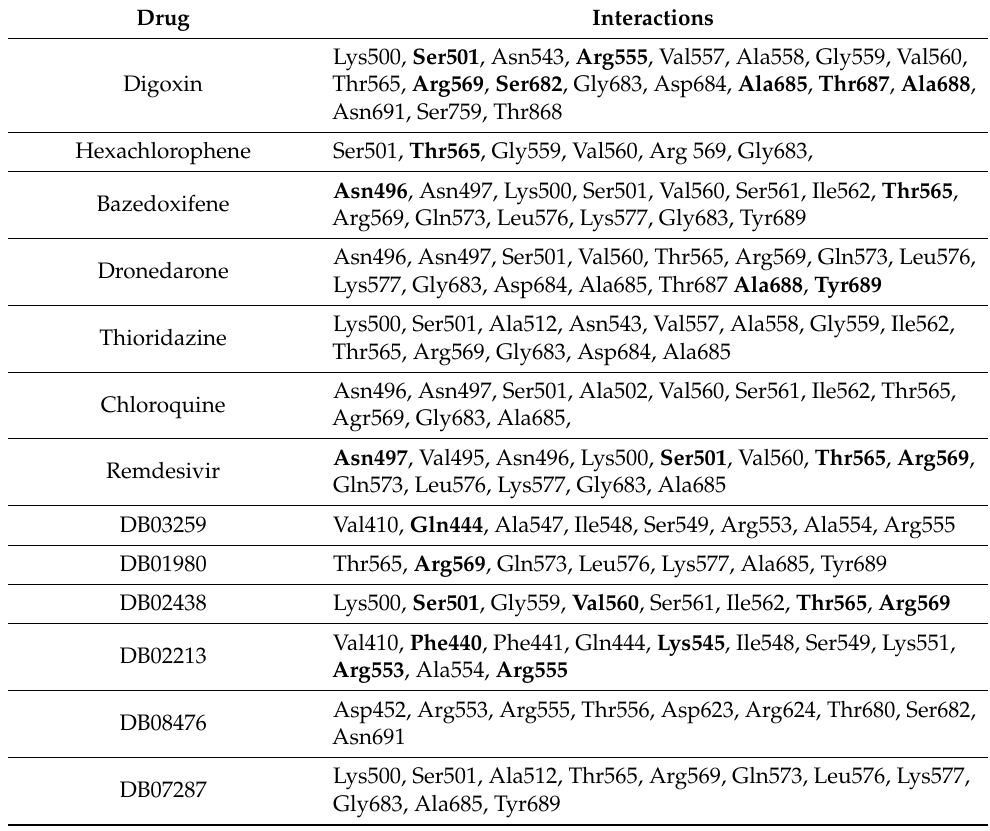
Table 6. Interactions of different drugs with RdRp.